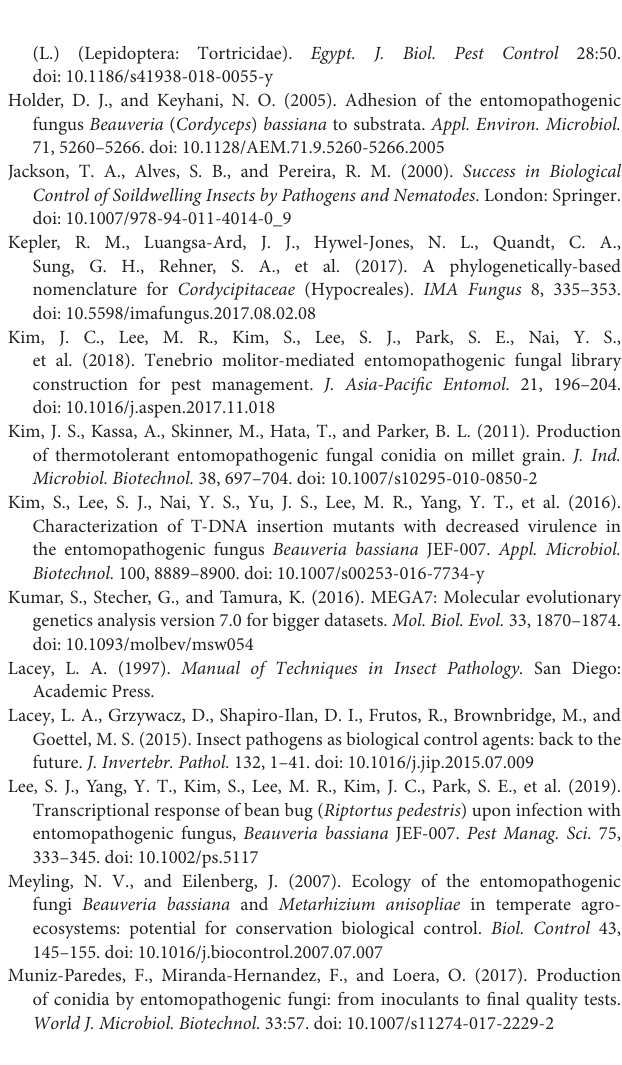
Supplementary Table 2 | The mortality rates obtained with primary pathogenicity screening of fungal isolates. Supplementary Table 3 | Genbank accession numbers of entomopathogenic fungi in this study. Supplementary Table 4 | Morphological data of four entomopathogenic fungal type